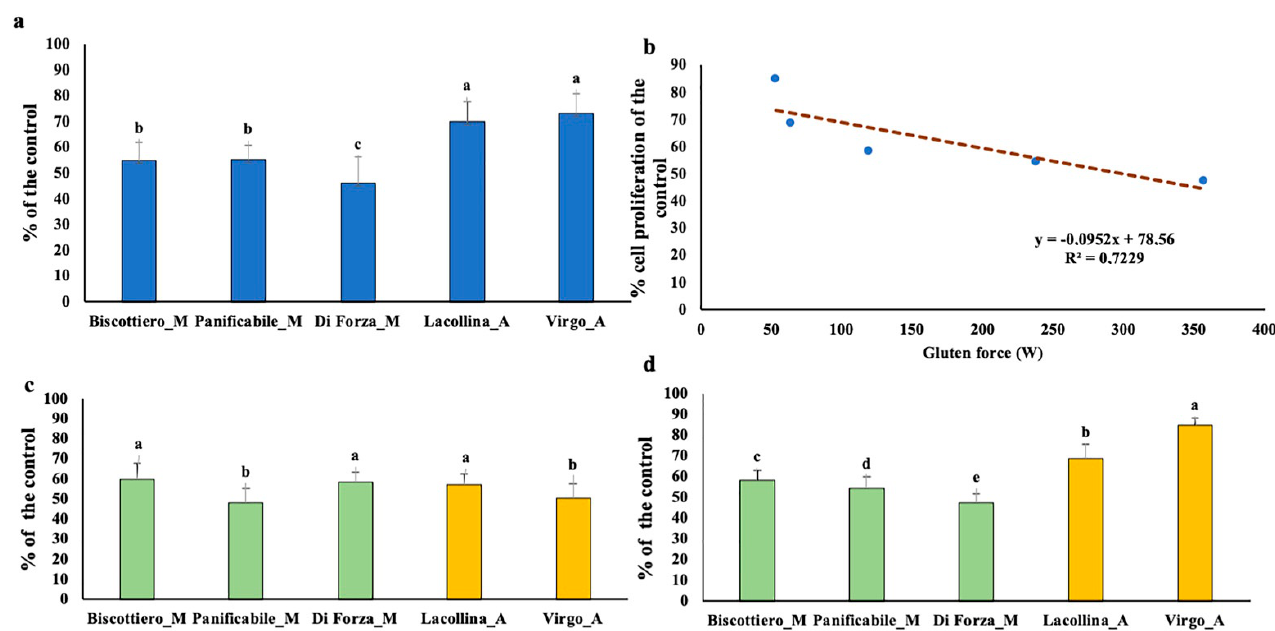
Figure 2. Cell proliferation (as a percentage of the untreated control) of Caco-2 cells after a 24 h exposure to ( a ) 40 µg/mL total protein (albumins + globulins + gliadins + glutenins), ( c ) 40 µg/mL albumins + globulin, and ( d ) 40 µg/mL gliadins and glutenins from three commercially available modern wheat mixes (denoted by M) and two old wheat mixes (denoted by A). The designation of the letters a, b, c, and d represents significant differences between varieties as determined by one-way ANOVA at the 95% confidence level ( p ≤ 0.05). ( b ) is the correlation between gluten strength and effect on cell proliferation of the total protein extract.